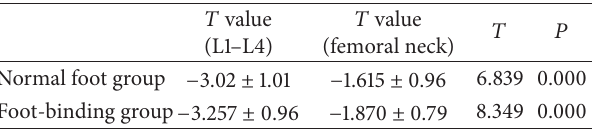
Table 7: The lumbar spine and femoral neck bone mineral density (normal foot group 𝑛 = 46 ; foot-binding group 𝑛 = 56 ).